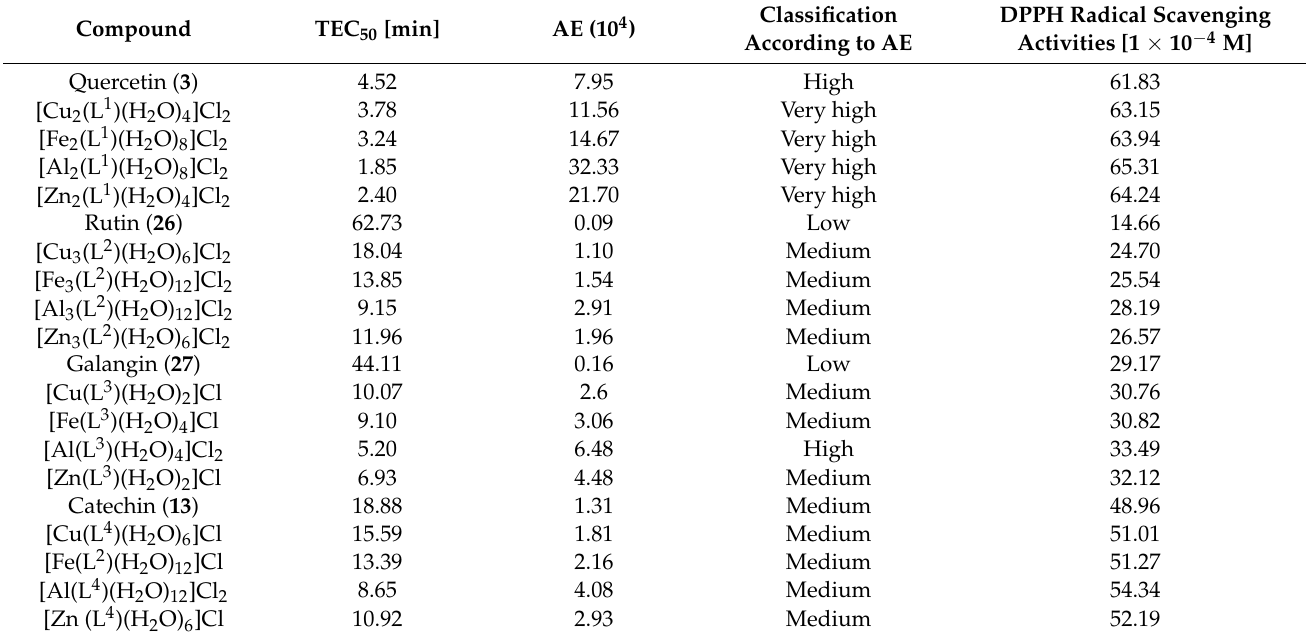
Table 1. TEC 50 and AE values, scavenging ratio of DPPH and antioxidant activities classification [246]. Compound